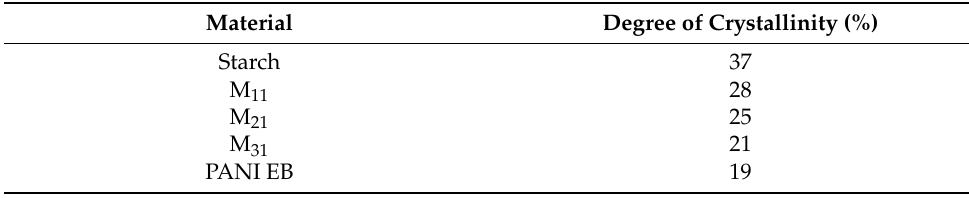
Table 5. Degree of crystallinity of starch, PANI-EB, and their biocomposites.